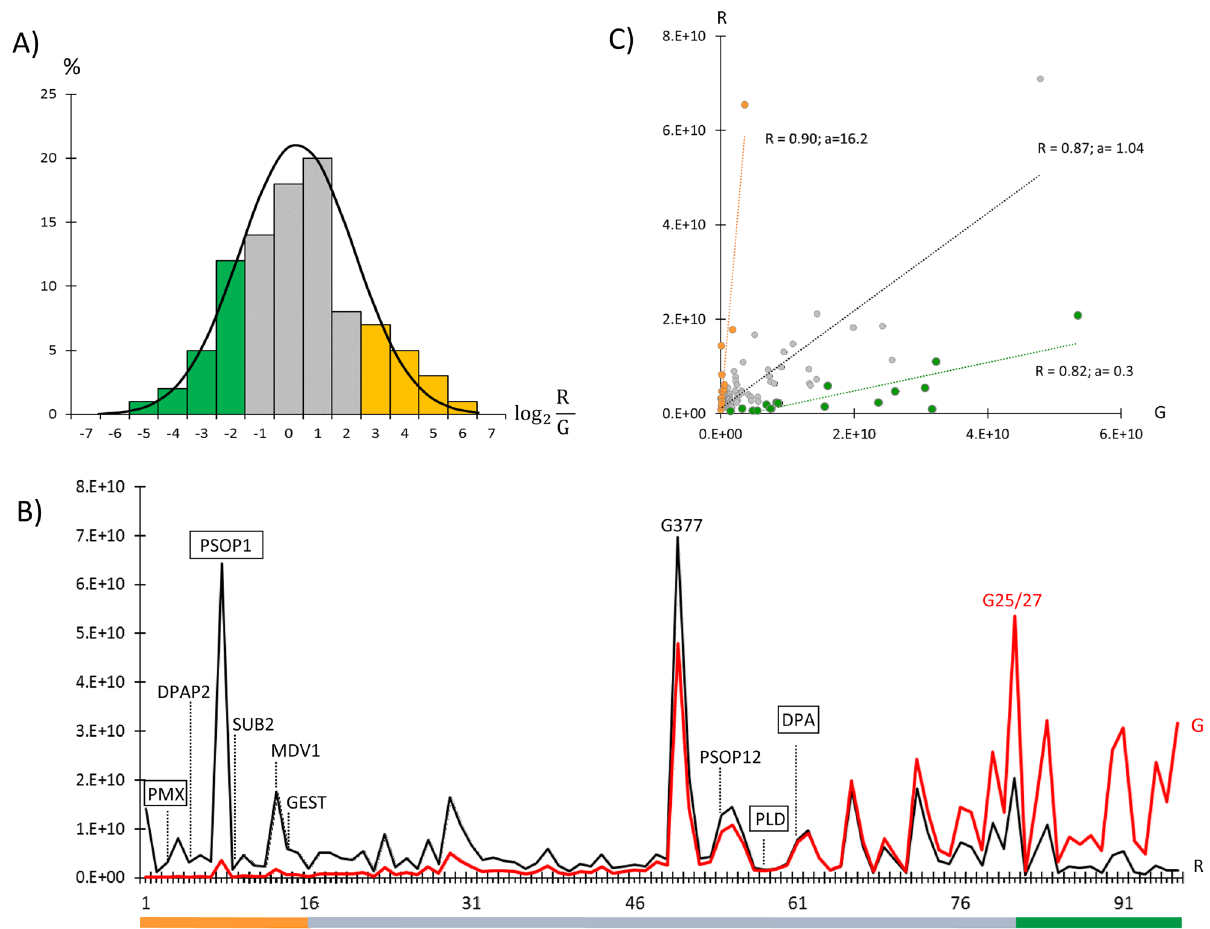
Figure 2. Statistical analysis of the proteome released by activated gametocytes. ( A ) The log2 distribution of the ratio between the mean abundance values of released proteome R and those of the same protein dataset in total gametocytes G (R/G) is shown as a bar chart; black line represents the corresponding fit Gaussian function. Orange and green bars highlight values exceeding the mean (m = 0.8) plus and minus one standard deviation (sd = 2.1) respectively. ( B ) G (red line) and R (black line) abundance profiles are ranked according to descending log2 ratio values. The orange bar below the plot corresponds to Top3 ratio values higher than the mean of at least one standard deviation; the green bar to ratio values lower than the mean of at least one standard deviation; the grey bar to values around the mean. Abundances of known egress markers (DPAP2, SUB2, MDV1, GEST G377 and PSOP12), selected egress-related candidates (boxed) and the contaminant G25/27 are indicated. ( C ) Plot of R vs G highlights protein abundance values around the mean (gray dots) and, values exceeding one standard deviation from the mean (orange and green dots). The correlation values R (ANOVA P ≤ 10–3, alpha = 0.05) and the linear coefficient (a) of the regression lines (dotted) are